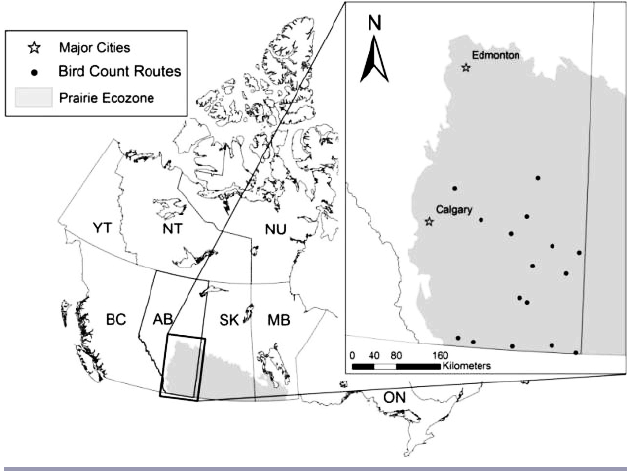
Fig. 1 . Locations of point count surveys used for assessing differences in bird communities on roadside and off-road survey routes within the Prairie Ecozone (shaded area) of southern Alberta,